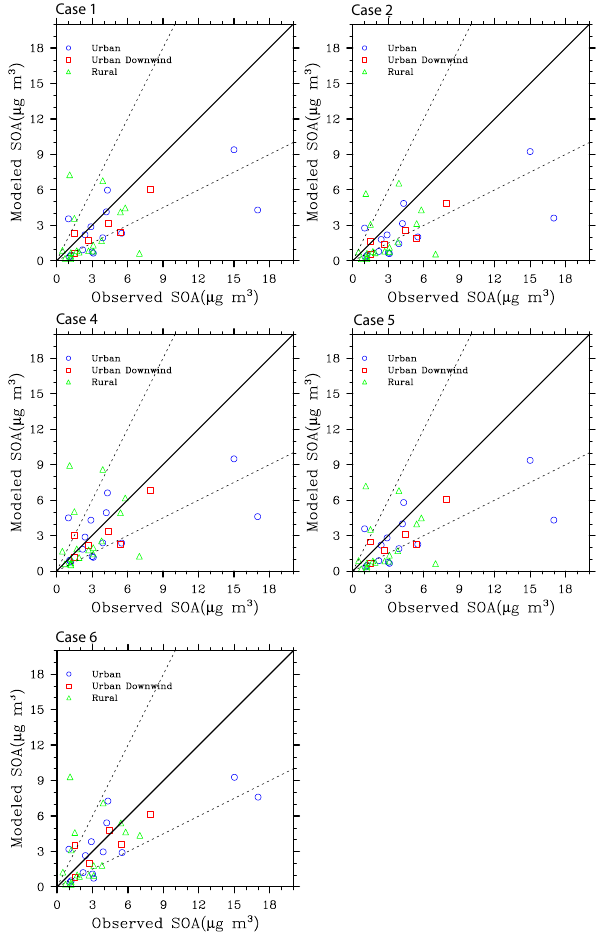
Figure 7. Comparison of SOA mass concentrations observed at the urban, urban downwind and rural sites reported in Zhang et al. (2007) with those simulated in Case 1, Case 2, Case 4, Case 5 and Case 6. Solid lines show the 1:1 ratio, and dashed lines show the 1:2 and 2:1 ratios. The measurements at the various sites were made in different seasons and different years between 2000 and 2006 and were reported for the average of different durations spanning from 8 to 36 days. The model results are the average values over the same months as the observations.